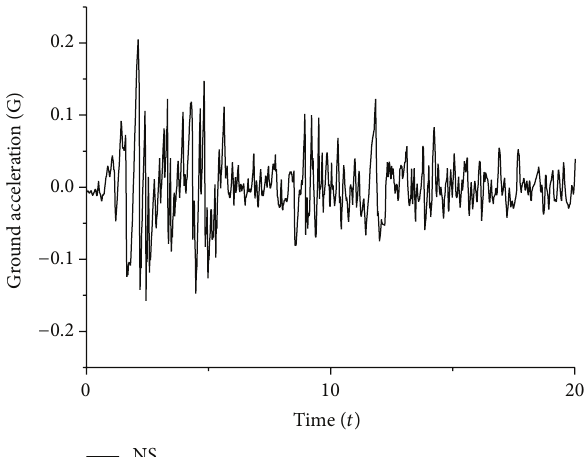
Figure 5: The El Centro wave time history with 0.35 g.